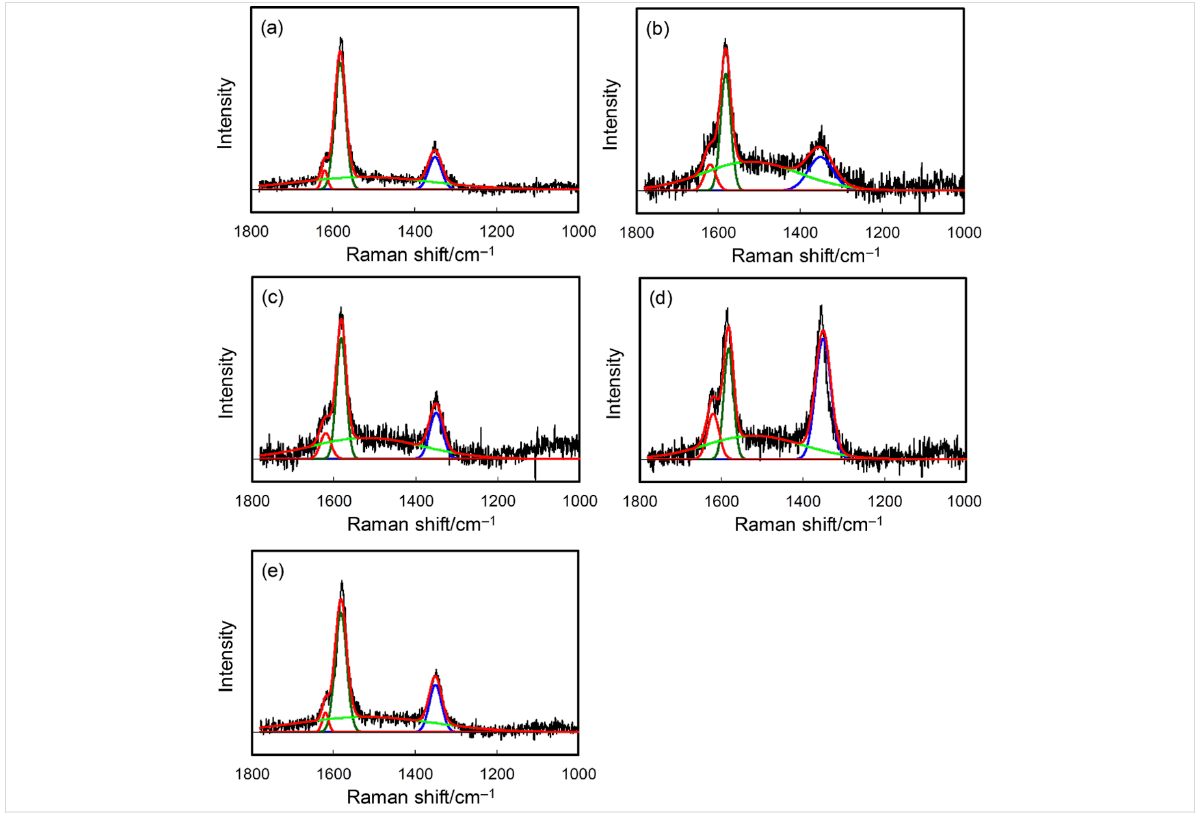
Figure 2: Raman spectra of (a) TGP, (b) TGP-CSnPc, (c) TGP-CSnPc-550Air, (d) TGP-CSnPc-650Air, and (e) TGP-550Air. The deconvoluted com- ponents, D2, G, Am, D, and the fitting result are shown in orange, green, light green, blue, and red lines, respectively. The spectra of